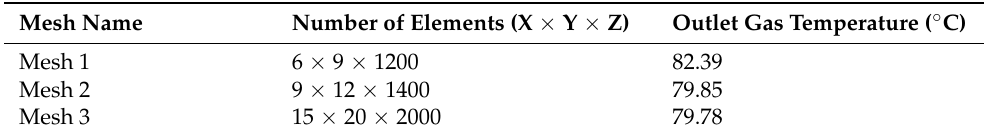
Figure 4. Simplification of the calculation model of the regenerator. Table 3. Mesh independency test.